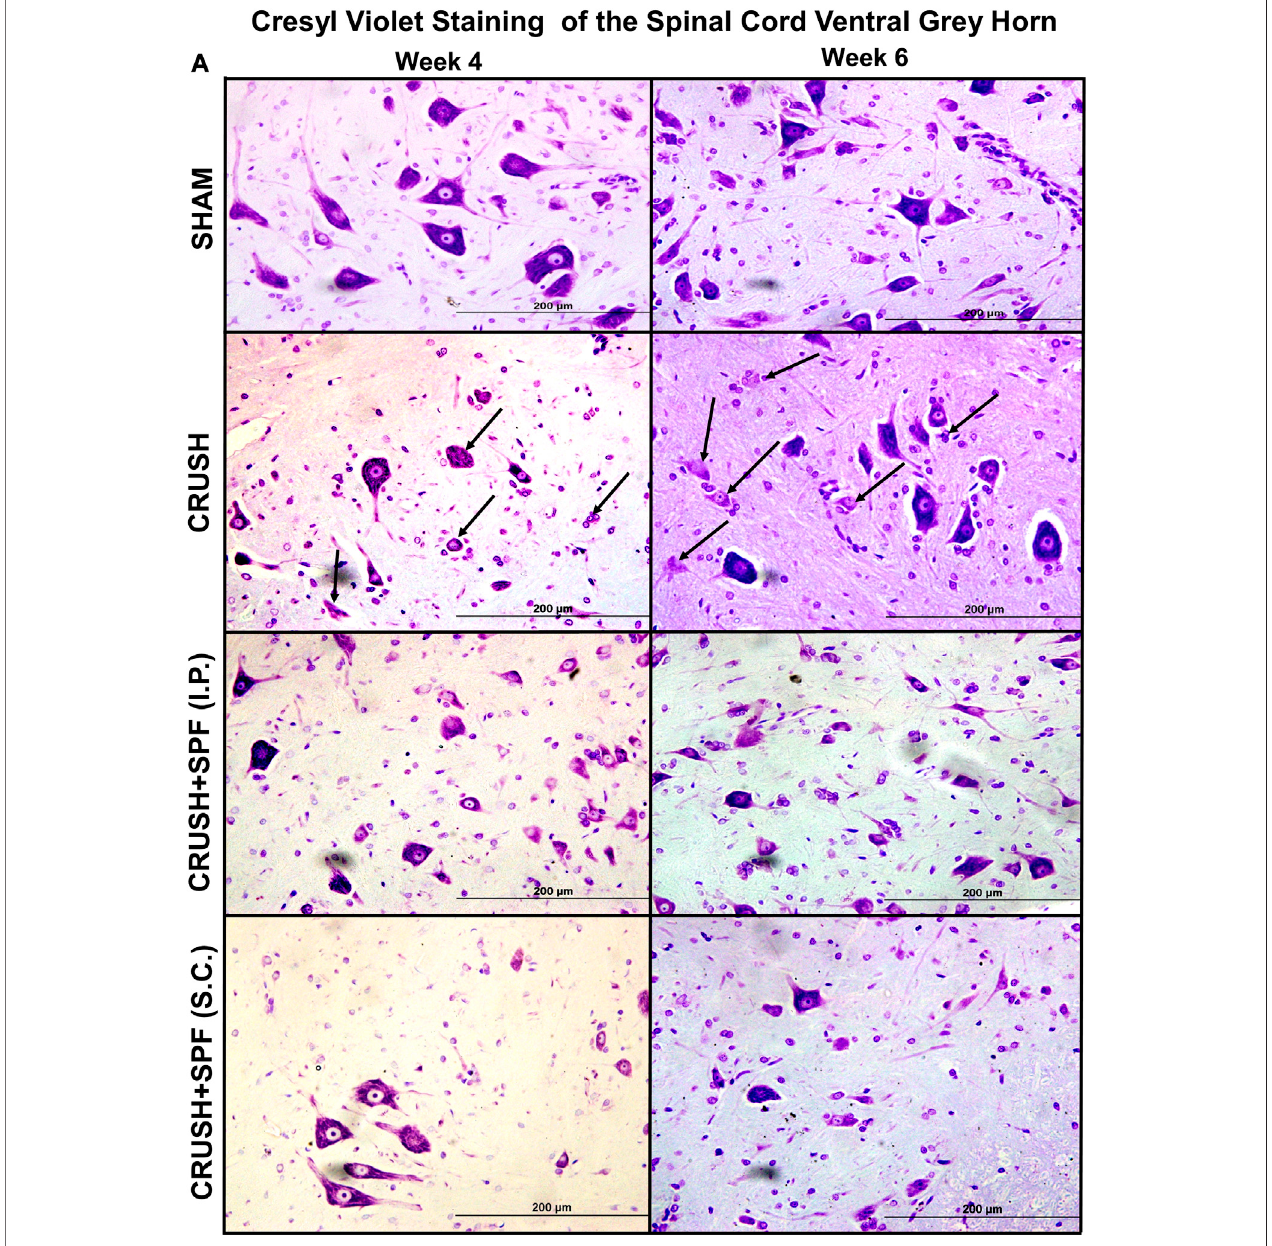
FIGURE 7 | Photomicrographs of lumbar spinal cord (A) : ventral and (B) : dorsal grey horns from rats of all groups stained with Cresyl violet stain at Week 4 and Week 6 following sciatic nerve injury (100 × ). The degenerating neurons have prominent shrunken eosinophilic cytoplasm and are primarily characterized by nuclear pyknosis(eitherpyknoticorkaryorrhecticnuclei).Itisthisheterogeneousappearancethattypi fi esneuronaldegeneration.Notefewerneuronsanddegeneratingneurons (arrows) with less Nissl substance that appear pale because of the dissociation of ribosomes from the rough endoplasmic reticulum in the nerve-injured CRUSH than the SHAM group. The number of normally looking neurons is remarkably more in CRUSHvSPF-FB(IP) and CRUSH + SPF-FB(S.C.)-treated groups than the CRUSH group.